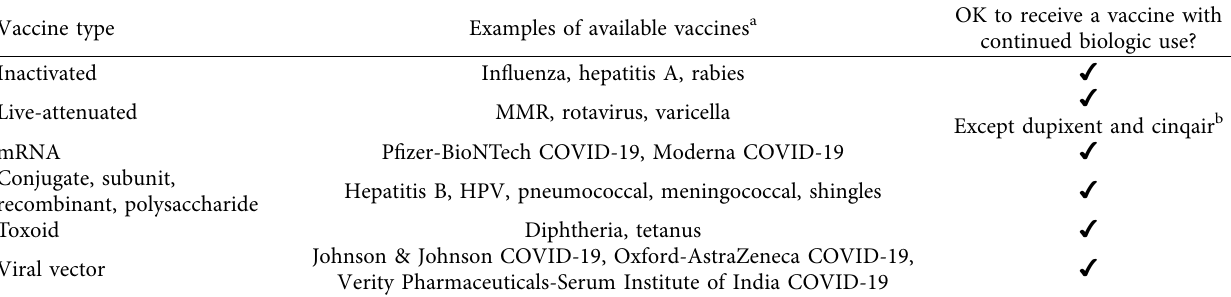
Table 2: Types of vaccines and whether to administer with a biologic [4, 5, 6, 8, 9, 45]. Vaccine